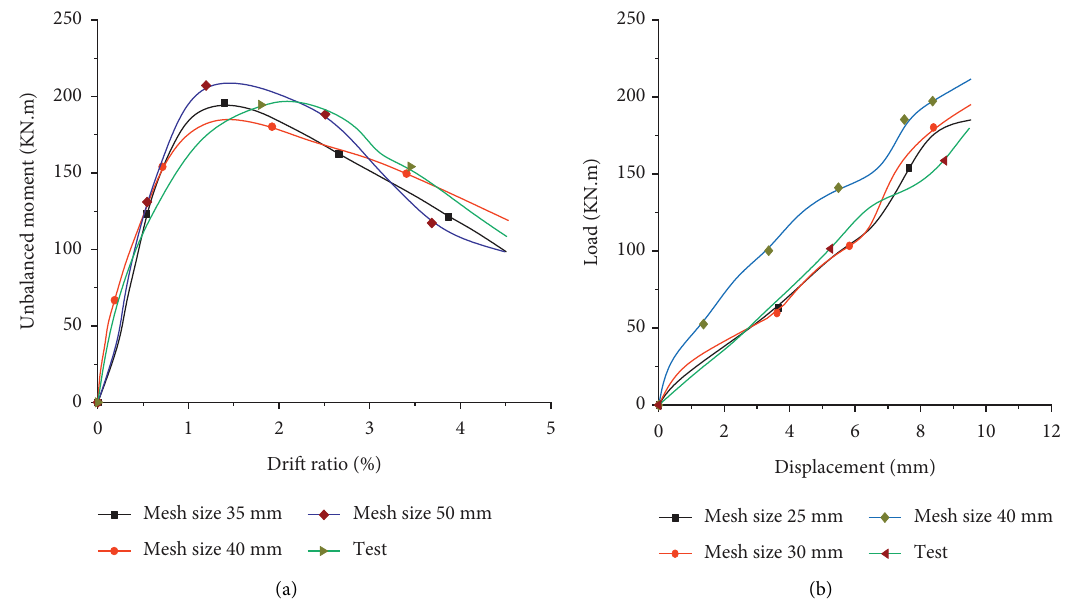
Figure 20: Mesh sensitivity study. (a) Efect of diferent mesh size for Part-I specimen. (b) Efect of diferent mesh size for Part-II specimen.